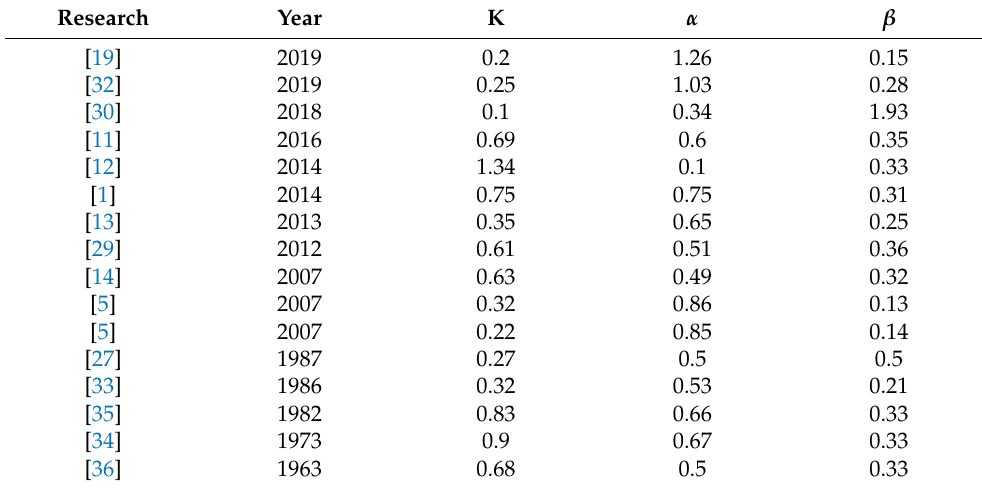
Table 1. Coefficients for specific models in the literature to predict masonry compressive